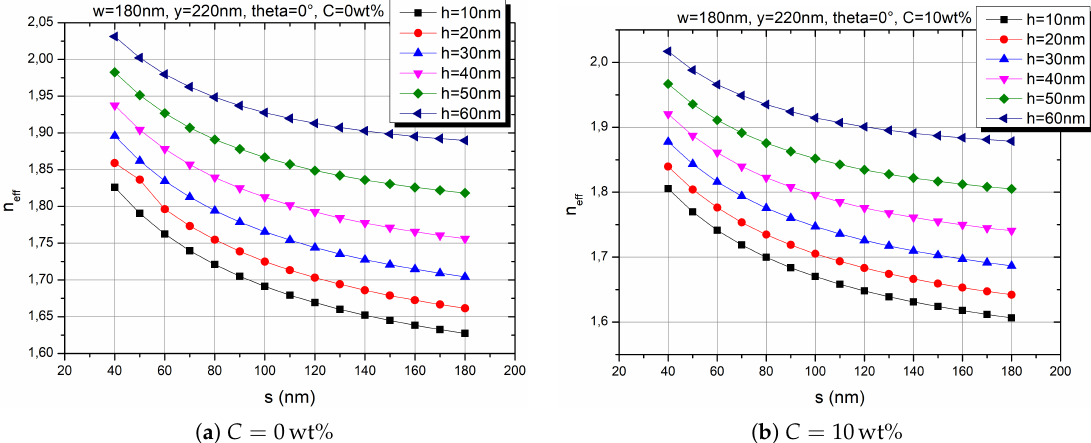
Figure A5. Effective refractive index n eff for both concentrations as a function of s and with h as